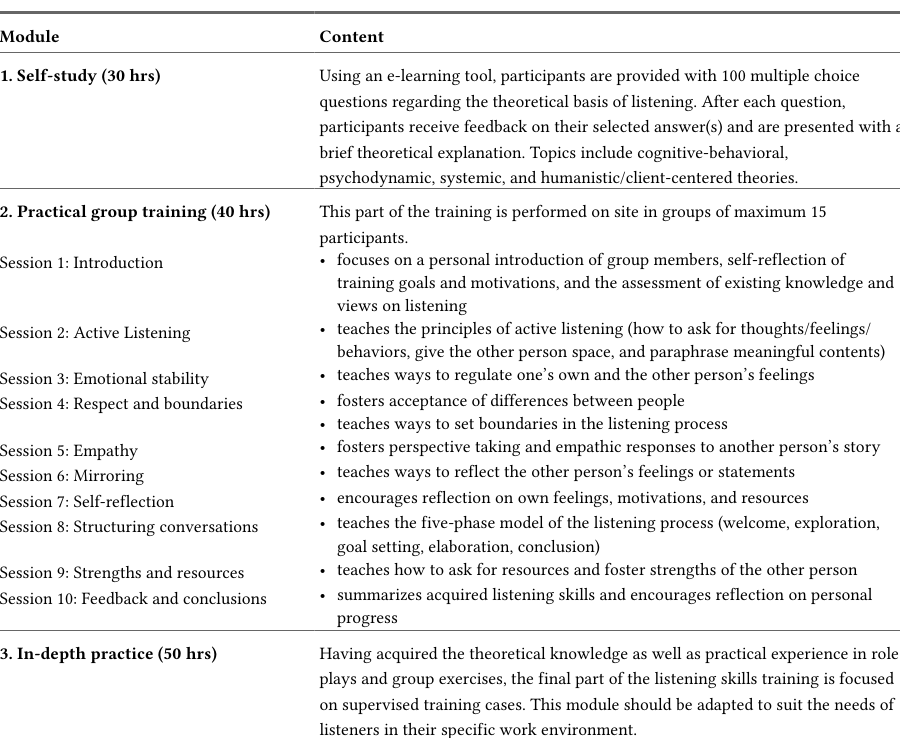
Description of Contents of the Listening Skills Training Modules Module